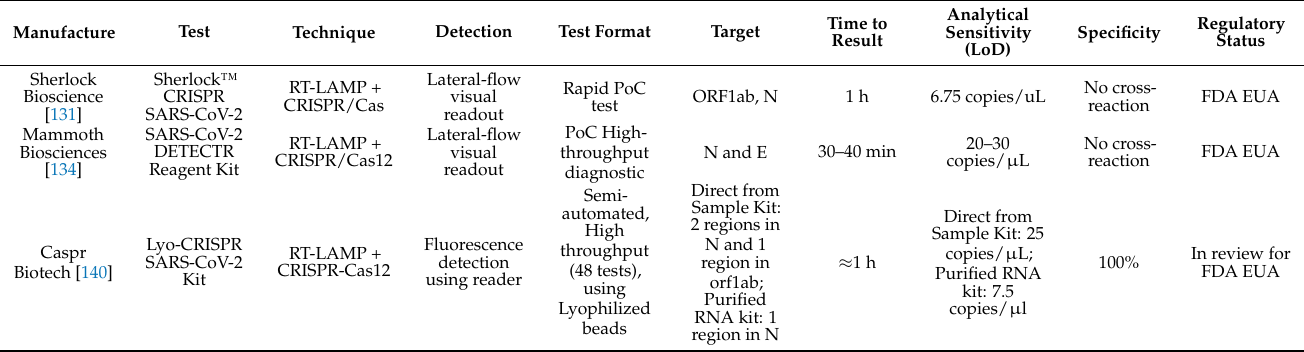
Table 3. CRISPR-based tests for COVID-19